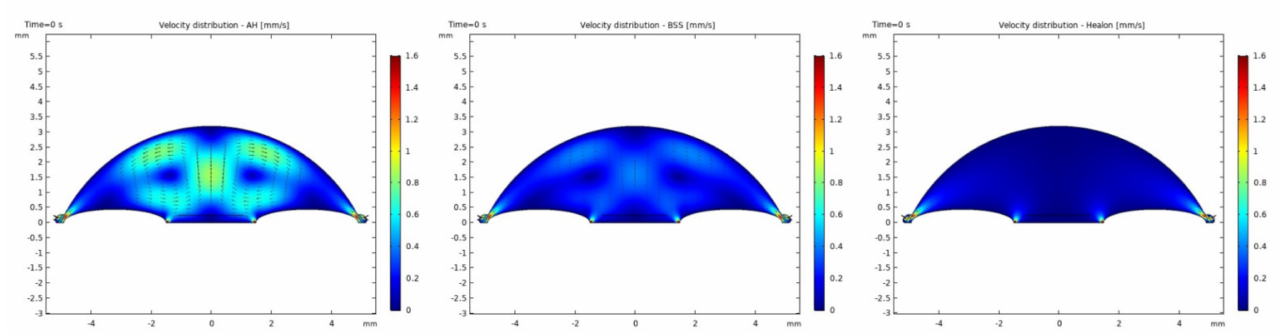
Figure 3. Initial temperature distributions with AH, BSS and Healon.